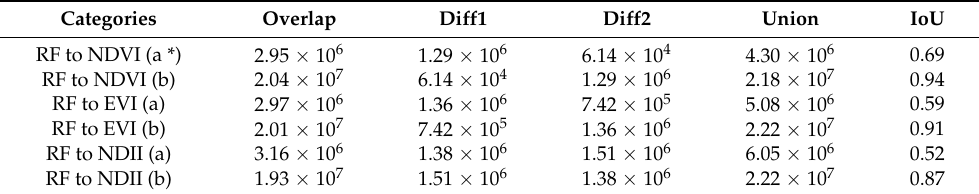
Table 2. Image overlap and union (IoU) area (grid pixel numbers) and the IoU between RF method and UID-VI methods.